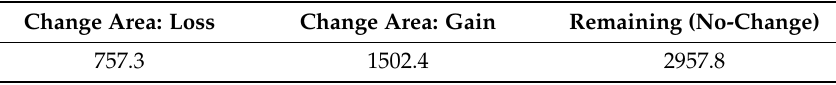
Table 4. The total area of changed and un-changed Impervious Surface in km 2 .